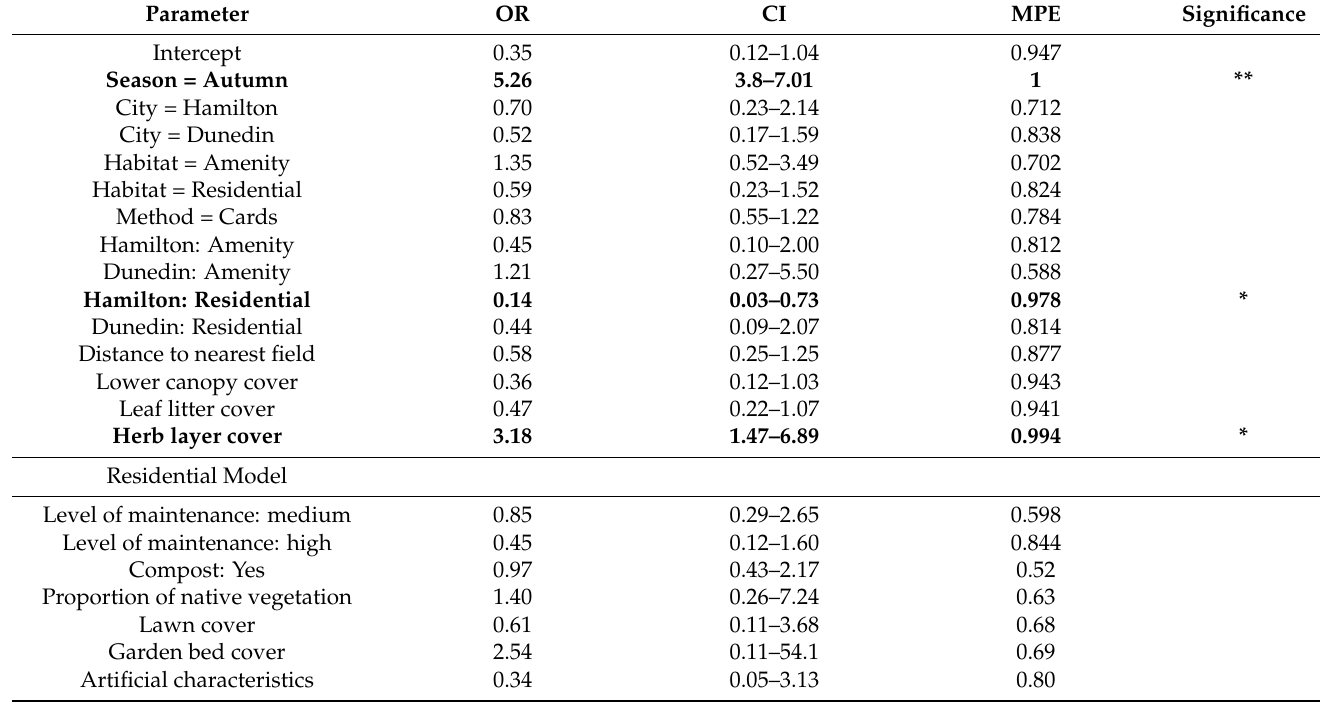
Table 4. Mice: summary statistics for coefficients of the parameters in the main mouse model, and additional residential model